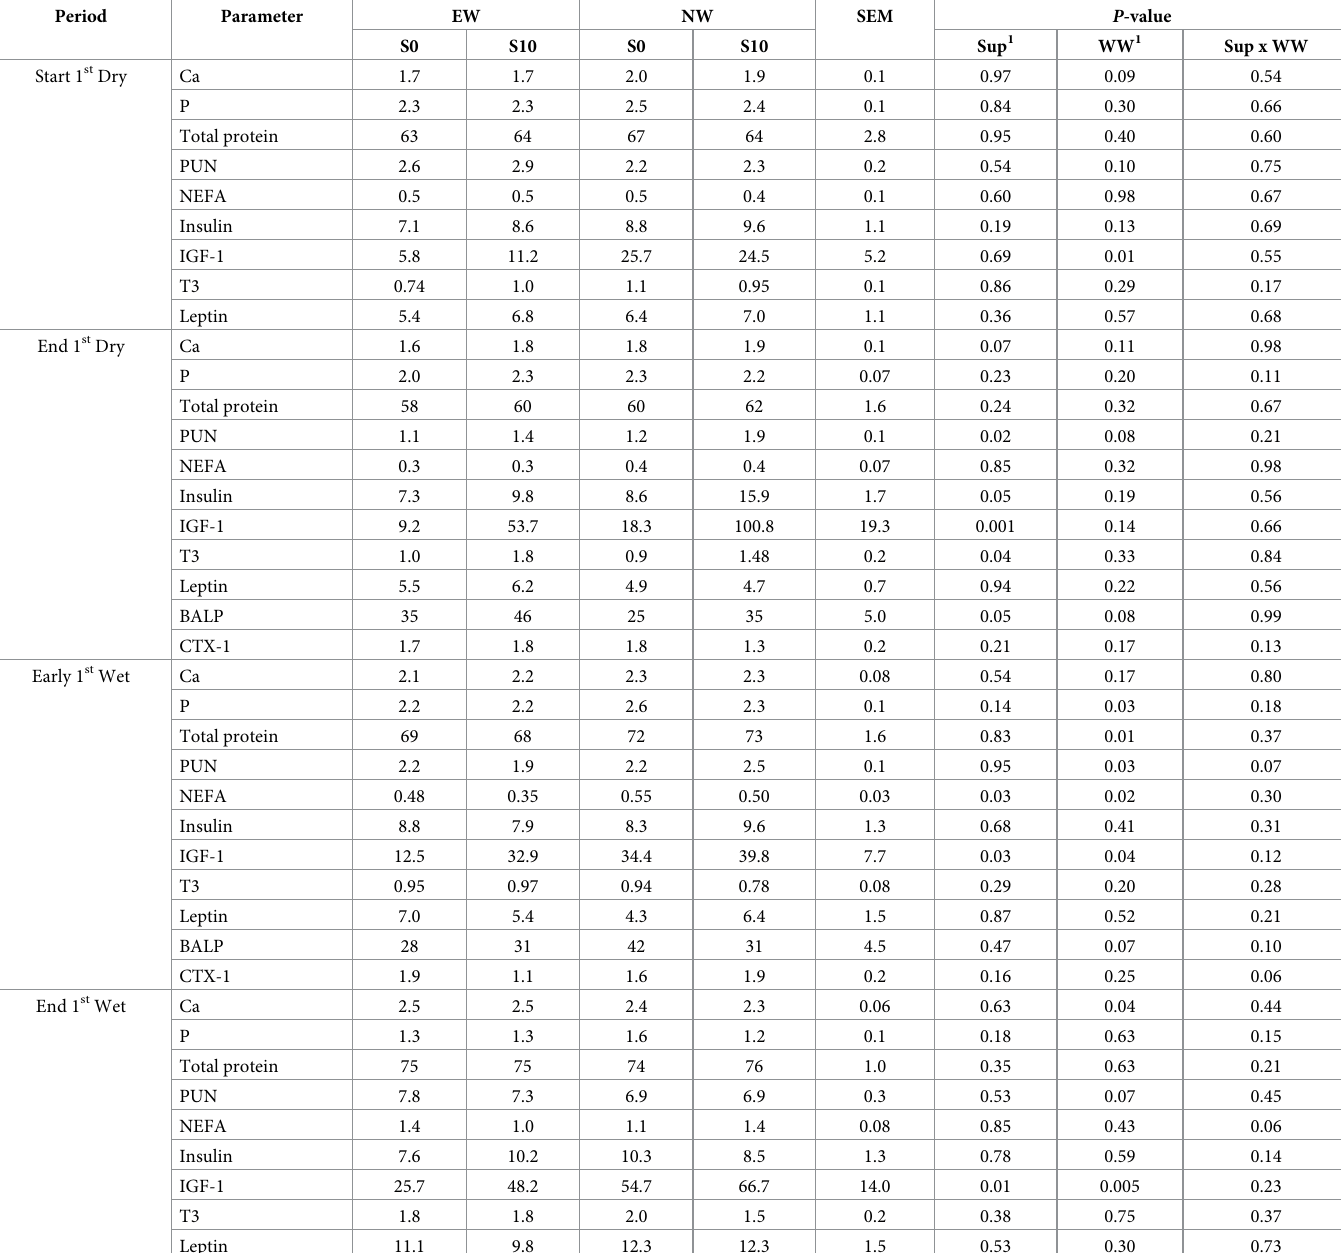
Table 3. The concentration of calcium (Ca; mmol/L), phosphorus (P; mmol/L), total protein (mg/L), plasma urea-N (PUN; mmol/L), non-esterified fatty-acids (NEFA; mEq/L), insulin (IU/mL), insulin-like growth factor-1 (IGF-1; ng/mL), triiodothyronine (T3; nmol/L), leptin (ng/mL), bone-specific alkaline phosphatase (BAP; U/L) and C-terminal telopeptides of type I collagen (CTX-1; ng/mL) in the plasma of early (EW) and normally (NW) weaned crossbred Brahman heifers fed two different supplement treatments 1 during the first dry season 2,3 .